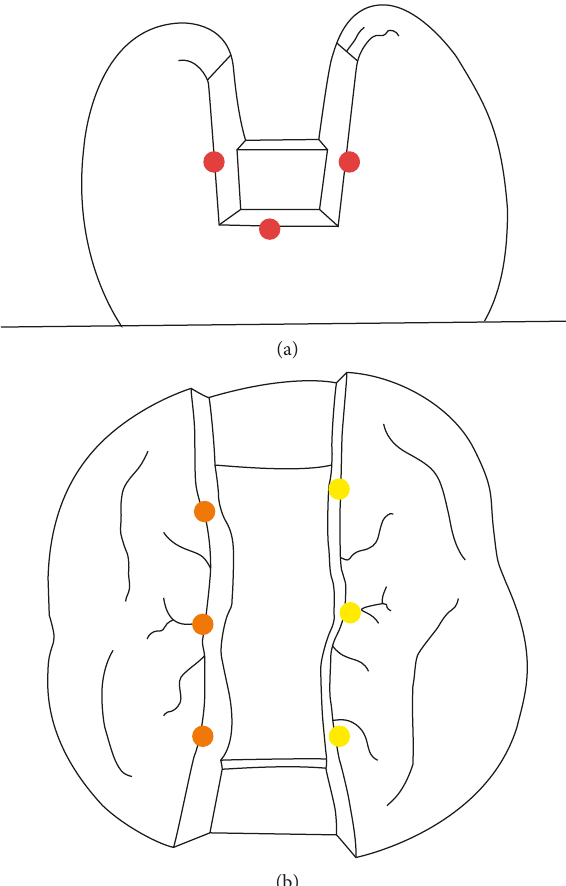
Figure 2: Marginal gap measurement points. (a) Location of measuring points mesially and distally. (b) Location of measuring points on the occlusal